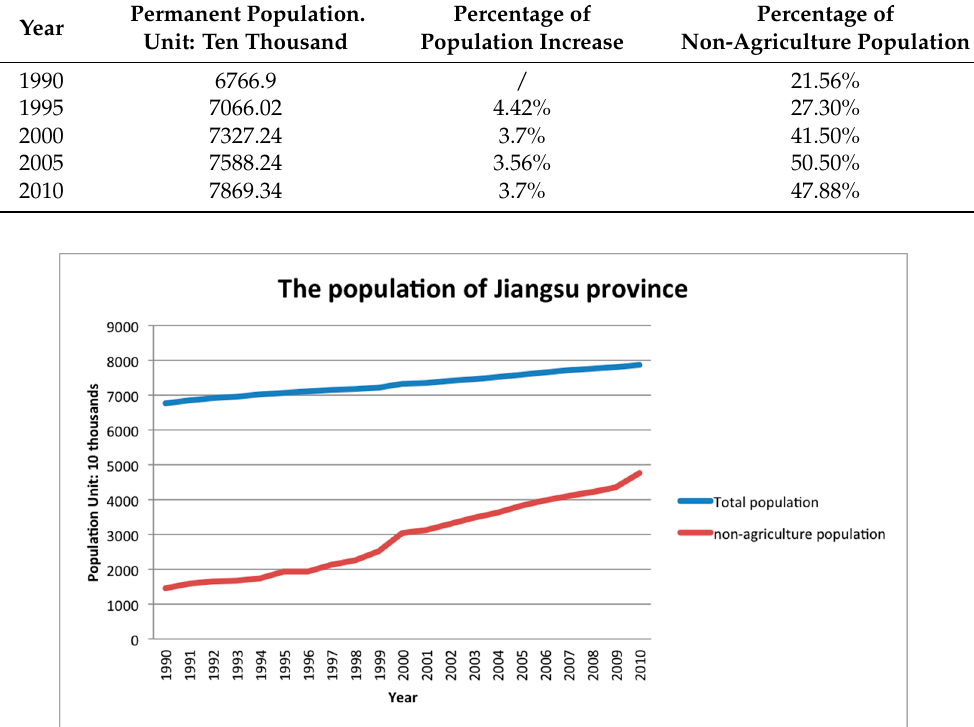
Figure 5. Population changes in Jiangsu province (unit: 10 thousand).